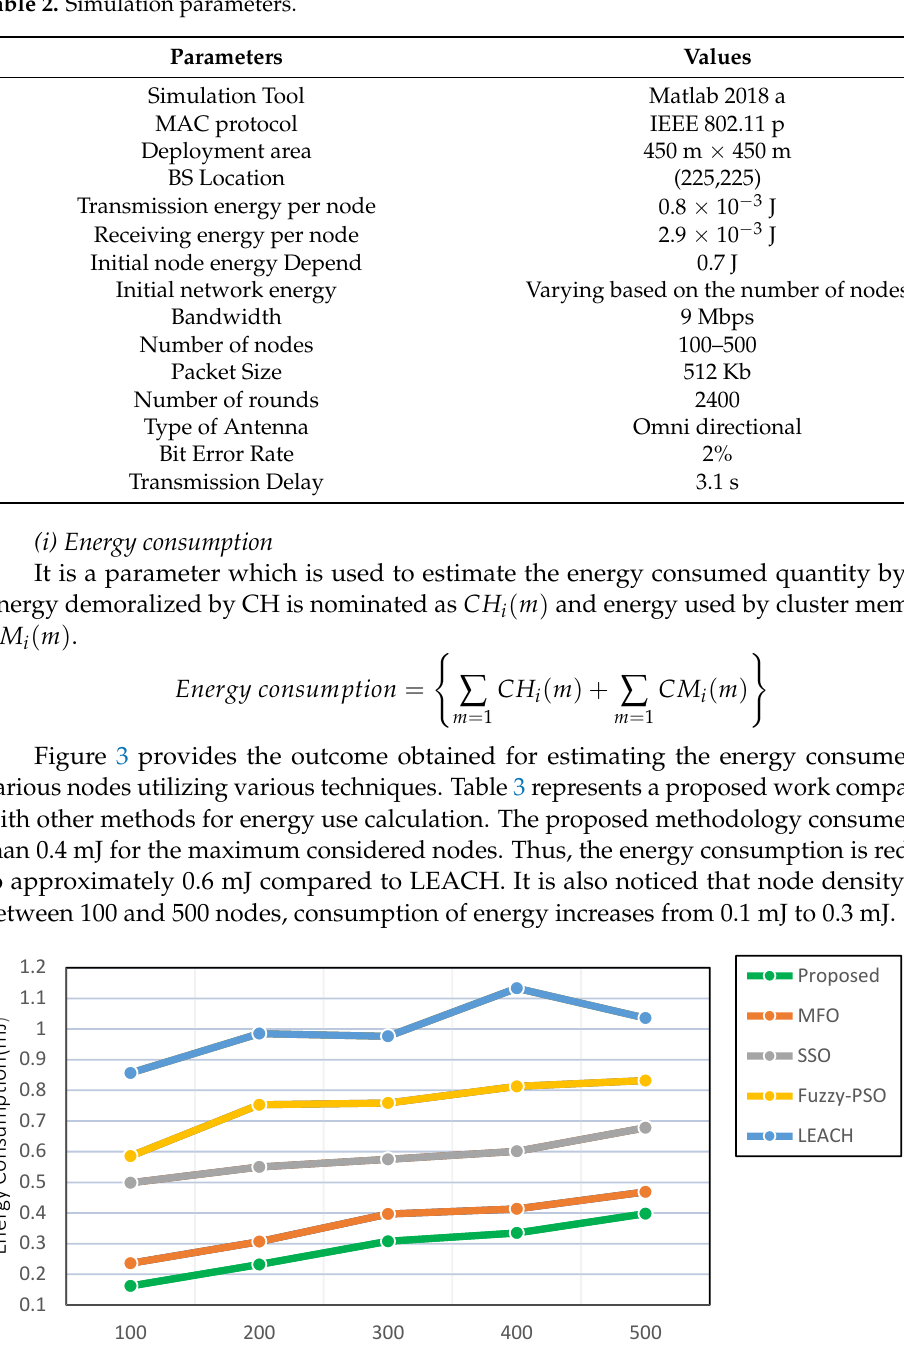
Table 2. Simulation parameters.